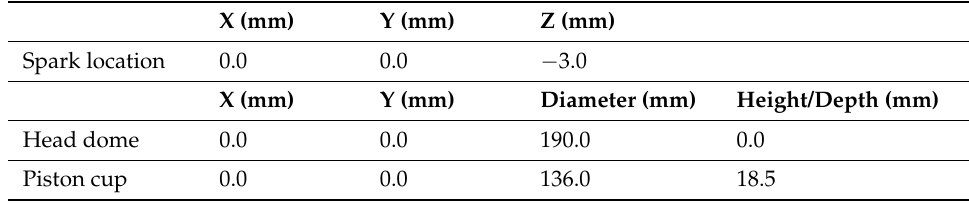
Table 3. Some flame object